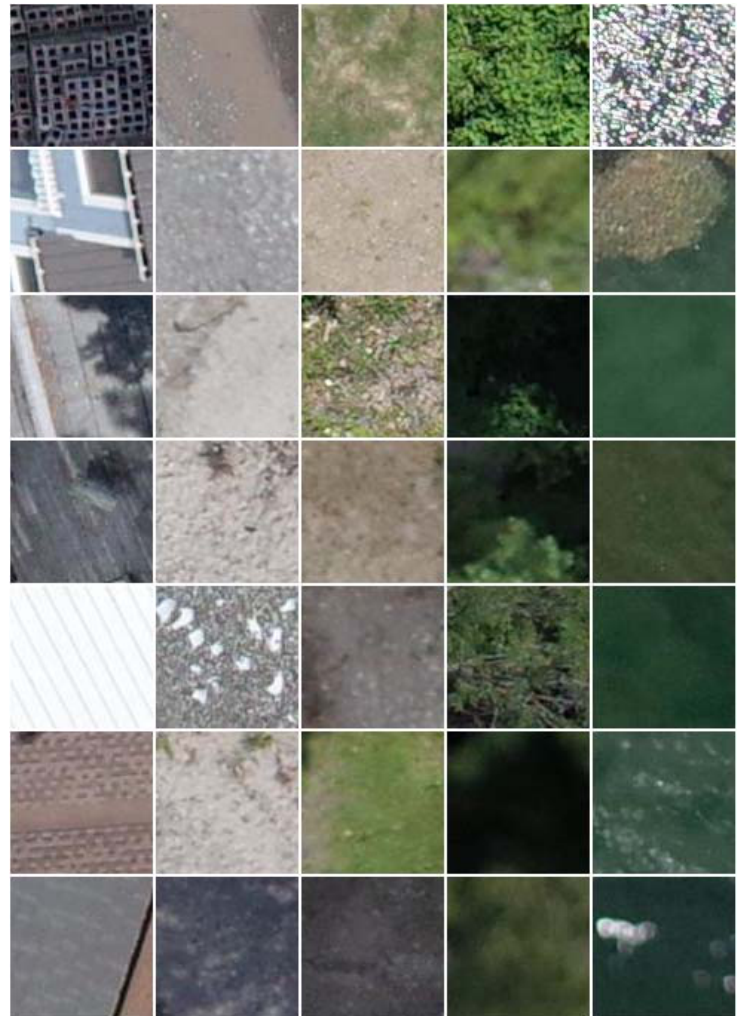
Figure 5. Example tiles from the Lake Ontario shoreline. Classes, in columns, from left to right, are anthropogenic/buildings, sediment, other natural terrain, vegetation, and water.